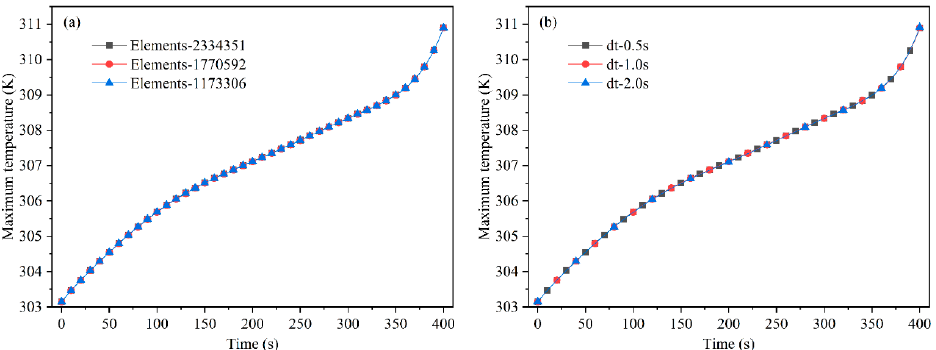
Figure 4. ( a ) Mesh sensitivity check; ( b ) Timestep sensitivity check.